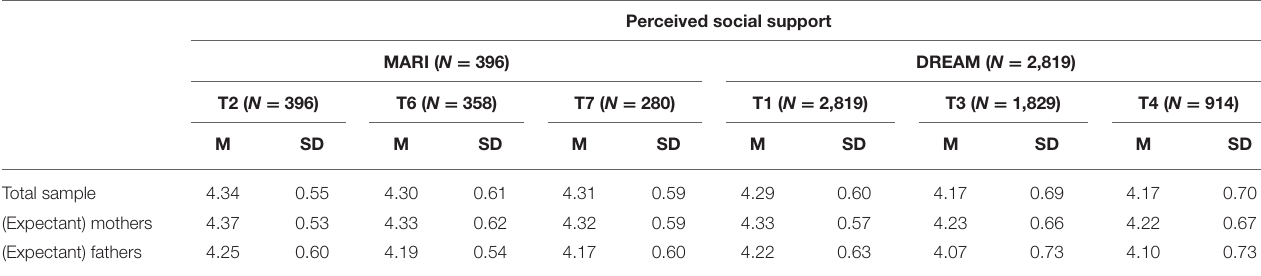
TABLE 4 | Means and standard deviations of perceived social support at different assessment waves for (expectant) mothers and fathers in MARI (N = 396) and DREAM (N = 2,819) .